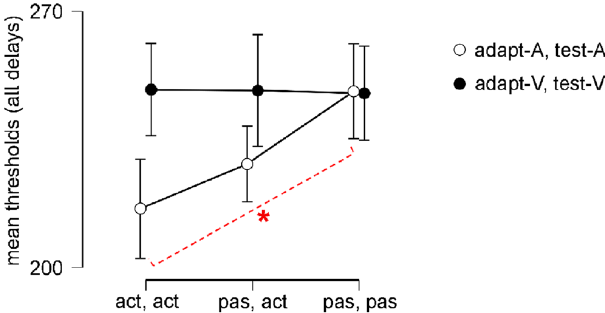
Figure 2. Line plots showing detection thresholds in the adapt-active, test-active (act, act), adapt-passive, test- active (pas, act) and adapt-passive, test-passive (pas, pas) conditions averaged across adaptation delays. Bold asterisk shows significant differences between conditions. Error bars represent the standard error of the mean (s.e.m.).